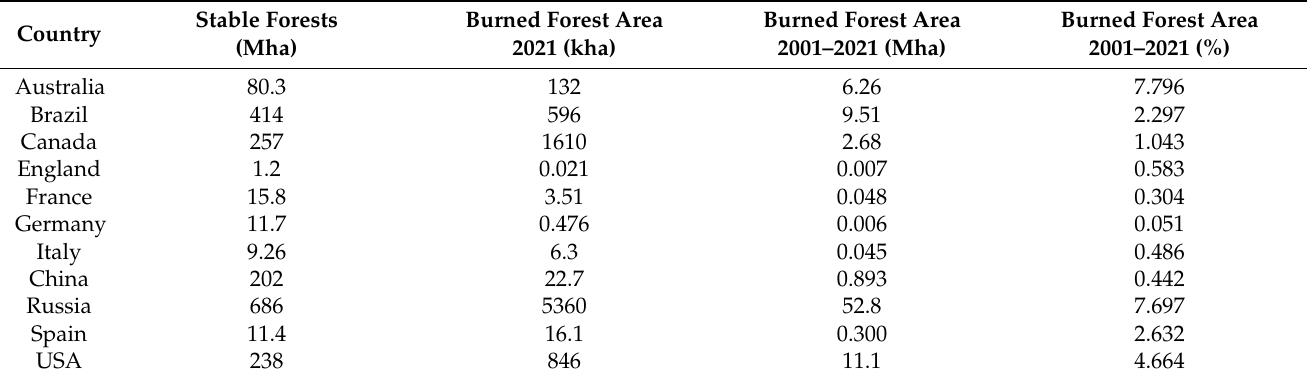
Table 1. Stable forests and lost forest area statistics by country between the years 2001–2021 [1].